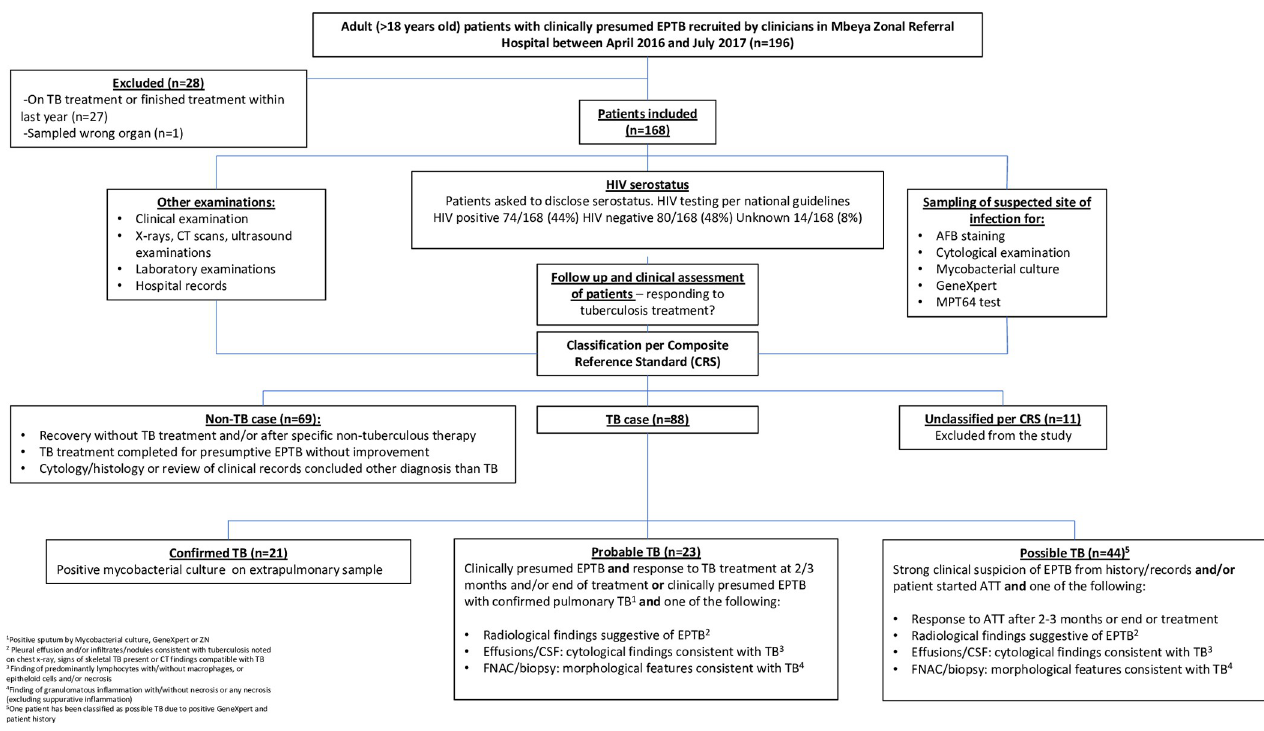
Fig 1. Study design, follow up and patient